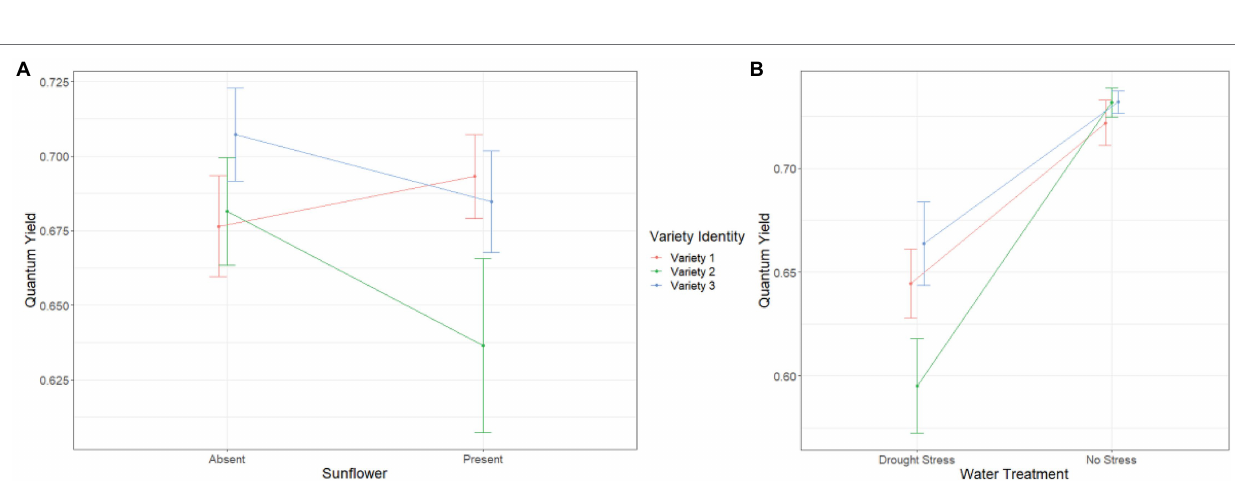
FIGURE 3 | Effect of (A) variety identity and sunflower presence, and (B) variety identity and drought stress treatment on quantum yield at week 8. Error bars represent